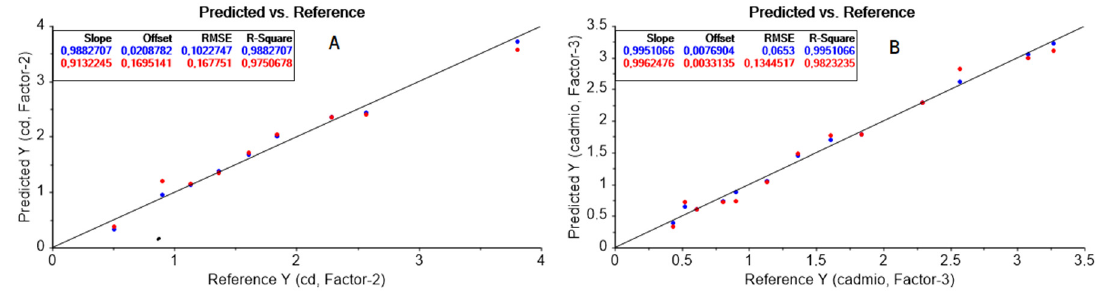
Figure 6. Cadmium (II) observed vs. predicted results for VIS ( A ), and MID–FTIR ( B ) data showing the fitting parameters during calibration (blue) and cross-validation (red). The reference line with zero intercept and with a slope of one is included. Table 2. Statistical parameters associated with the accuracy of the developed methods.